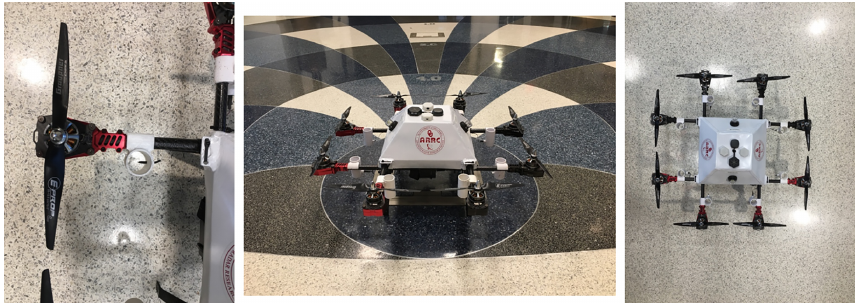
Figure 1. The CopterSonde, an octo-rotor UAS designed and built by the Center for Autonomous Sensing and Sampling at the University of Oklahoma.